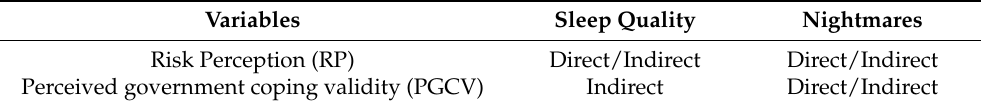
Table 4. Main results of